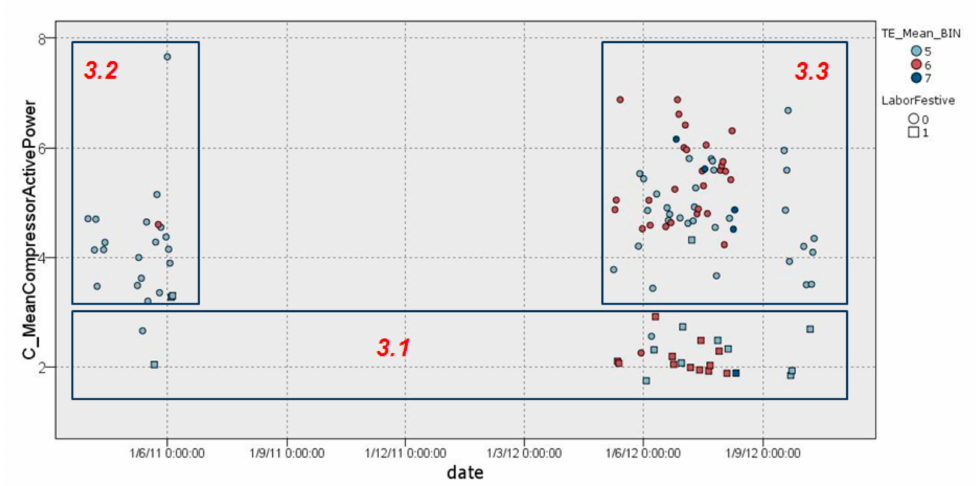
Figure 7. Graphical representation of distribution of cluster 3.